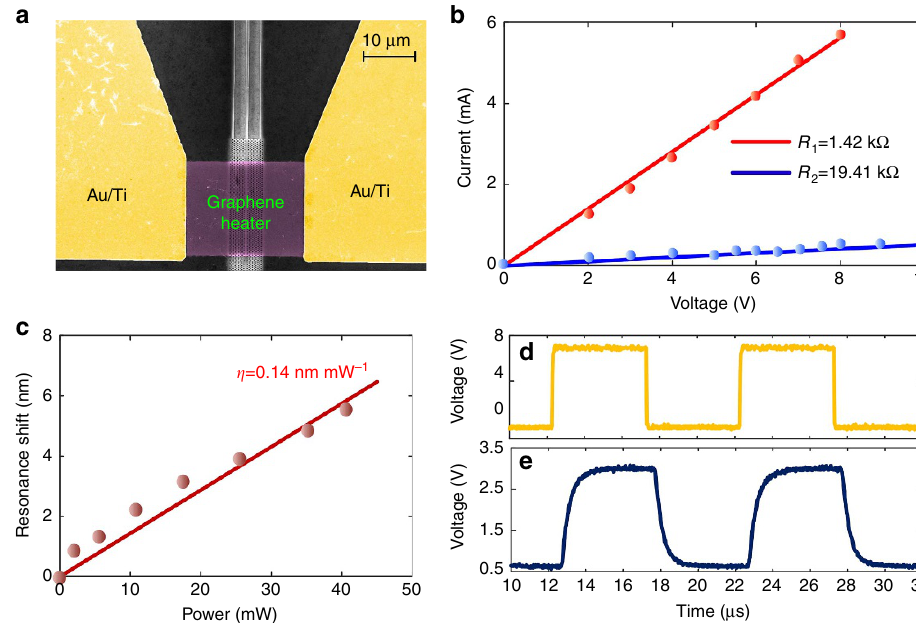
Figure 4 | Characterization of the straight-shaped graphene microheater. ( a ) False-colour scanning electron microscope image of the straight-shaped graphene heater. ( b ) Voltage–current relationship for the (blue line) Z-shaped and (red line) straight-shaped heaters. ( c ) Shift of the transmission spectrum as a function of the applied heating power for the straight-shaped heater. ( d ) Driving electrical signal and ( e ) corresponding modulated output signal of the